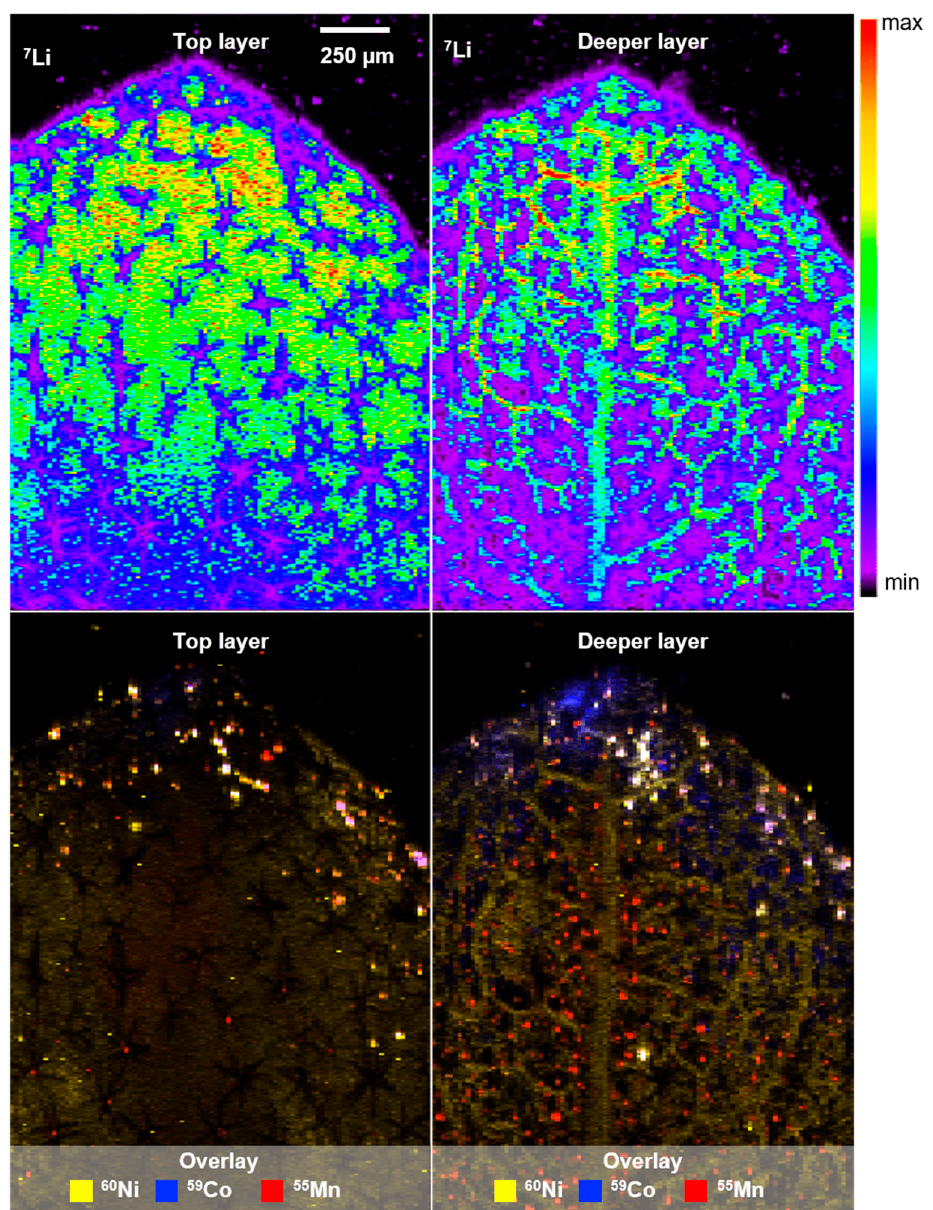
Figure 4. LA-ICP-MS image showing the Li distribution in the surface layer and deeper mesophyll (top), as well as the respective overlay of transition metal distribution (Ni, Co, Mn; bottom) in a leaf of alyssum murale . Co-localization of transition metals is shown in white.